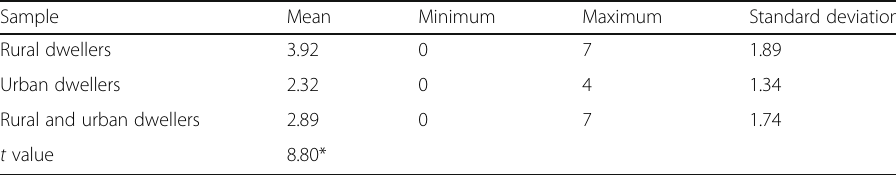
Table 2 Weekly consumption intensity of leafy AIVs among rural and urban dwellers Sample